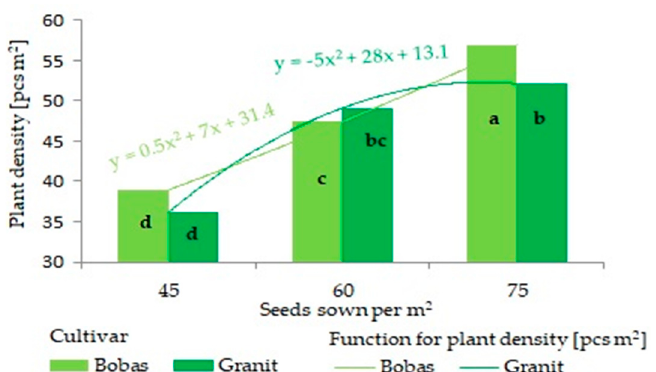
Figure 5. Plant density before harvest in 2011 (C × SDY). Different letters indicate significant differences between factors (Tukey’s multiple range test).